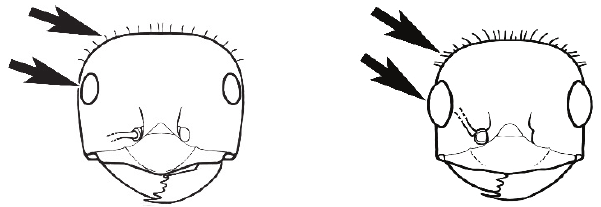
– Without this combination of characters: specifically, if with relatively large eye and modified setae on the periphery of the frons, then minor worker larger (HW > 0.73mm) and major worker head with fine microreticulation and pitting or iridescent (e.g., Fig. 60a); in other cases setae on frons long and